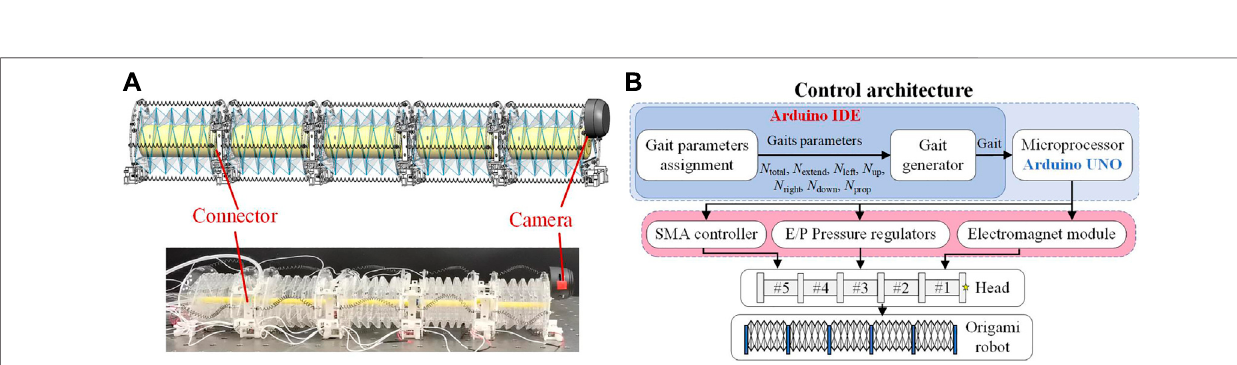
Frontiers in Robotics and AI |